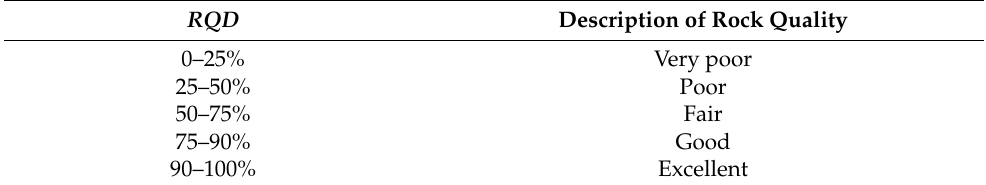
Table 1. RQD index and rock quality (Deere,